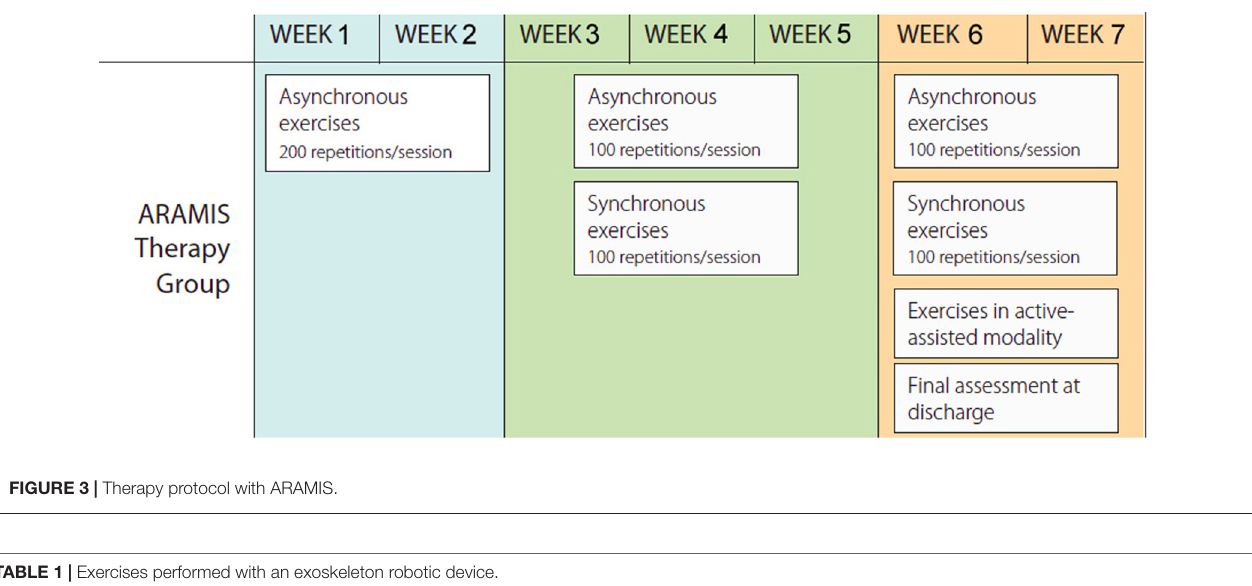
TABLE 1 | Exercises performed with an exoskeleton robotic